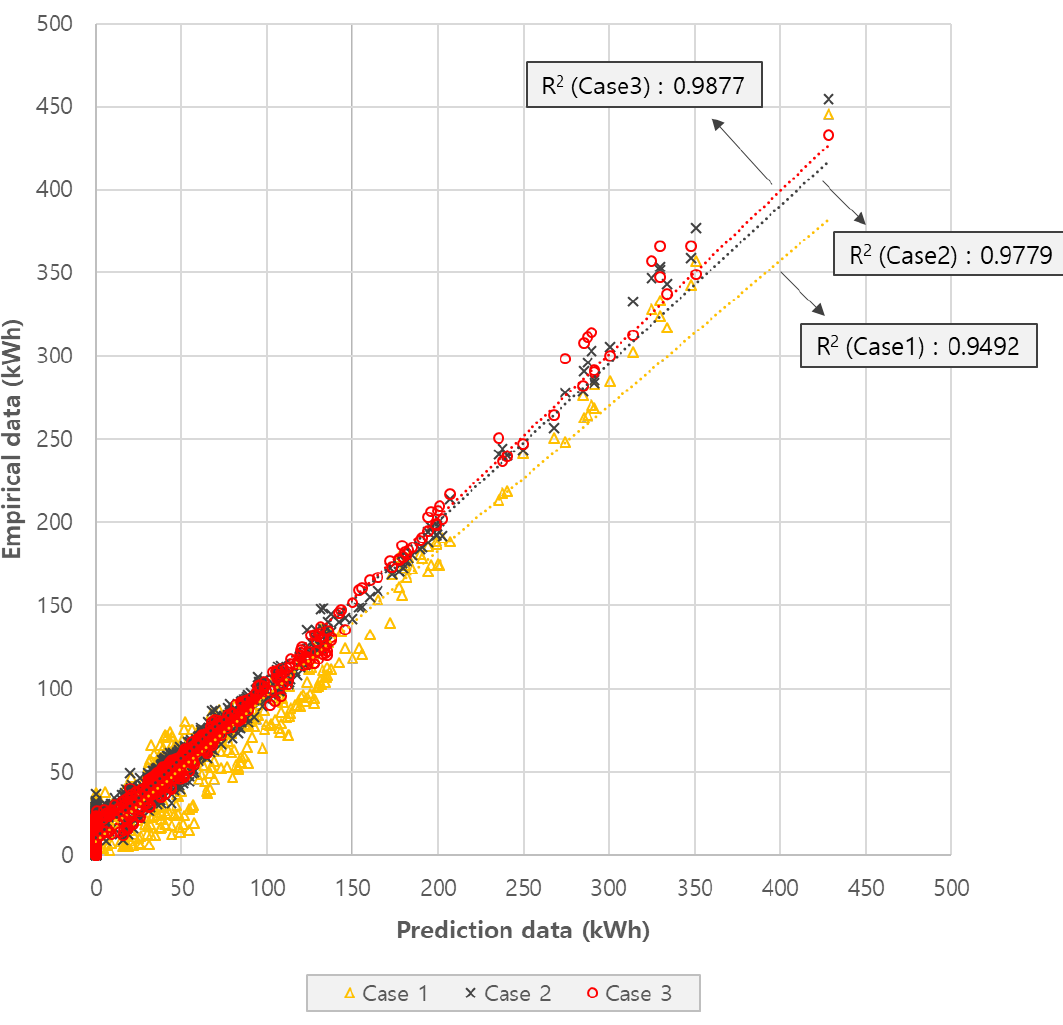
Figure 14. Comparison of the artificial neural network (ANN) model’s prediction results.